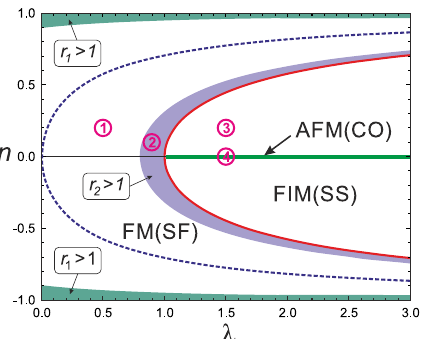
Figure 2. (color online) The ground state phase diagram of the hc bosons in the mean-field approximation. The solid line cor- 1) / ( λ + 1). The responds to SF-SS phase boundary, n 2 = ( λ − thick line at λ > 1, n = 0 shows CO phase. The dotted line, n 2 = λ/ ( λ + 1), separates the two types of the asymptotic be- havior in accordance with the expressions (16) and (17). In the shaded areas inside the SF phase region the characteristic lengths satisfy to inequalities r i > 1. The numbers 1-4 in the circles cor- respond to the parameters sets in figure